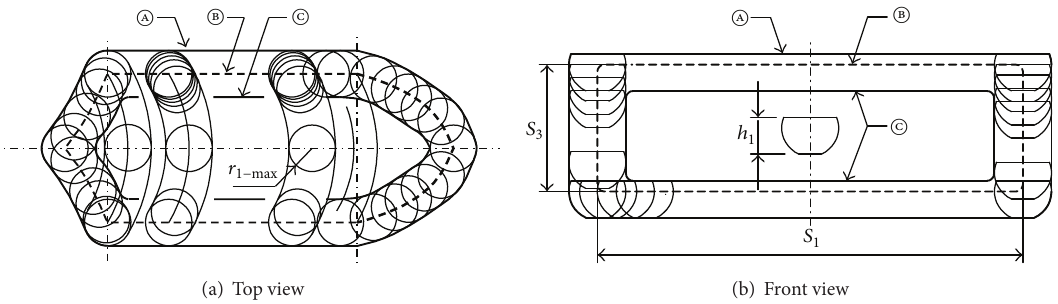
Figure 7: Projection of dexterous workspace of 𝑃 . The symbols (A), (B), and (C) represent the boundary of the reachable workspace of 𝑃 , the locus of the geometric center 𝑄 1 , and the boundary of the dexterous workspace of the selected point 𝑃 ,